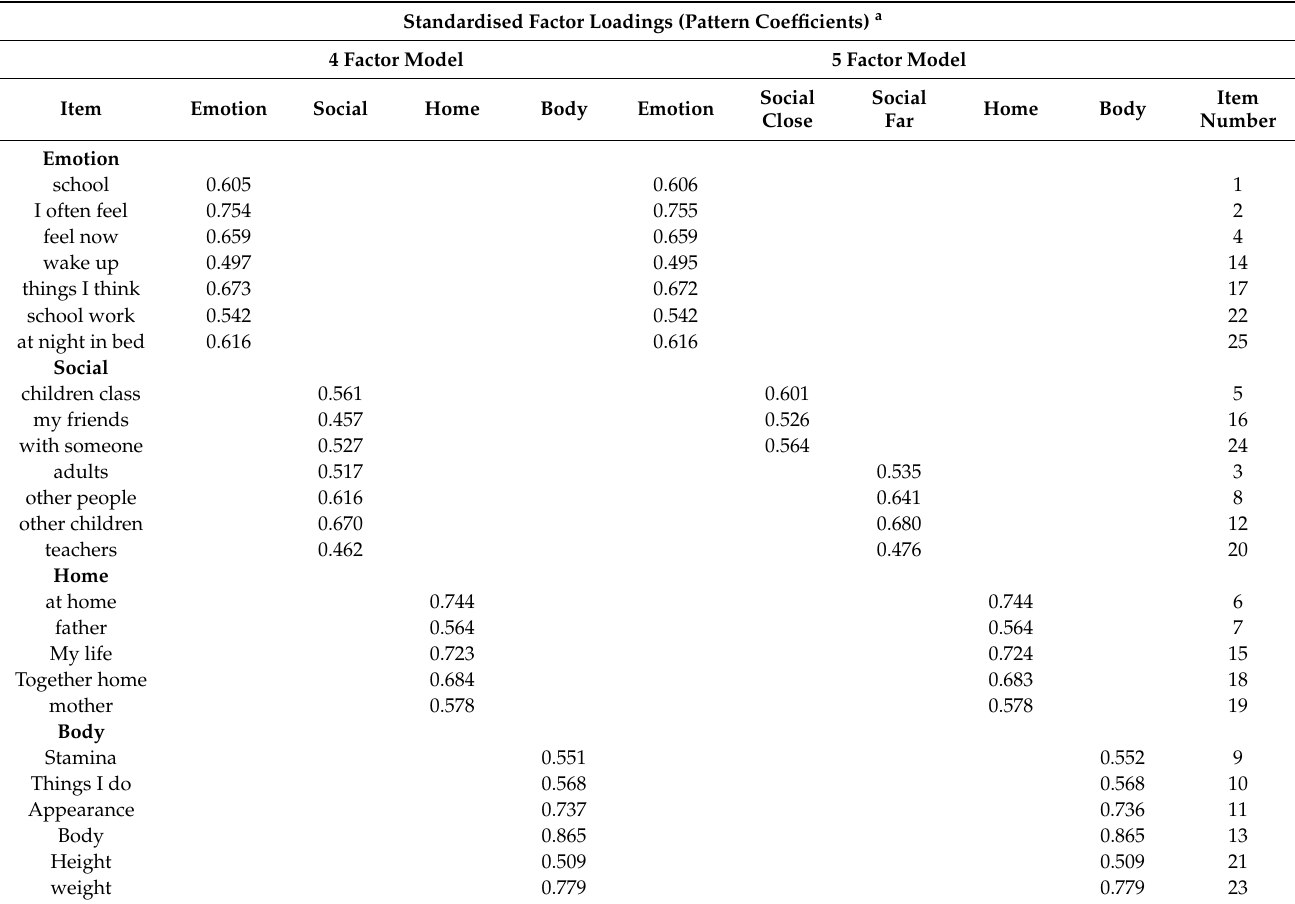
Table 2. Standardised Factor loadings for the 4 and 5 Confirmatory Factor